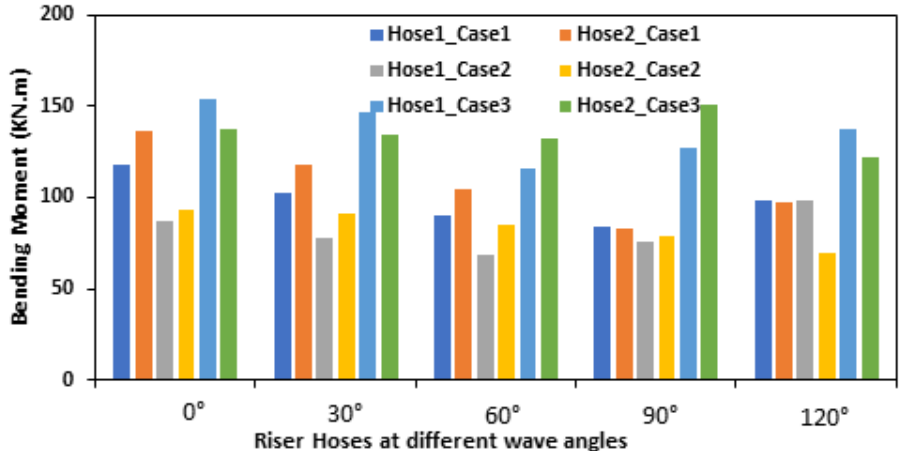
Figure 19. Bending moment profile for uncoupled model showing Hose1, Hose2, three sea states and five wave angles.